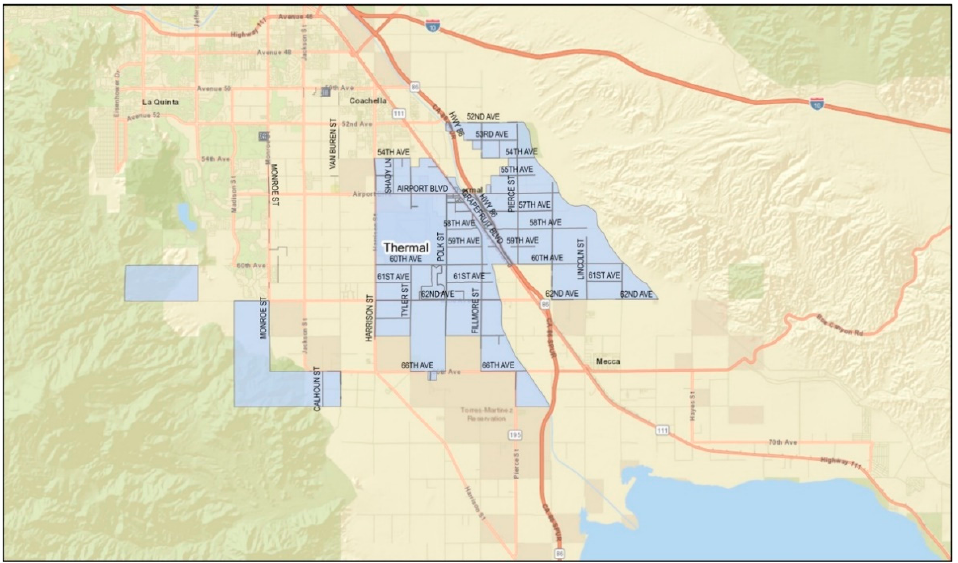
Figure 4. Geographical division of the community of Thermal. (Source: Riverside University Health System—Public Health).